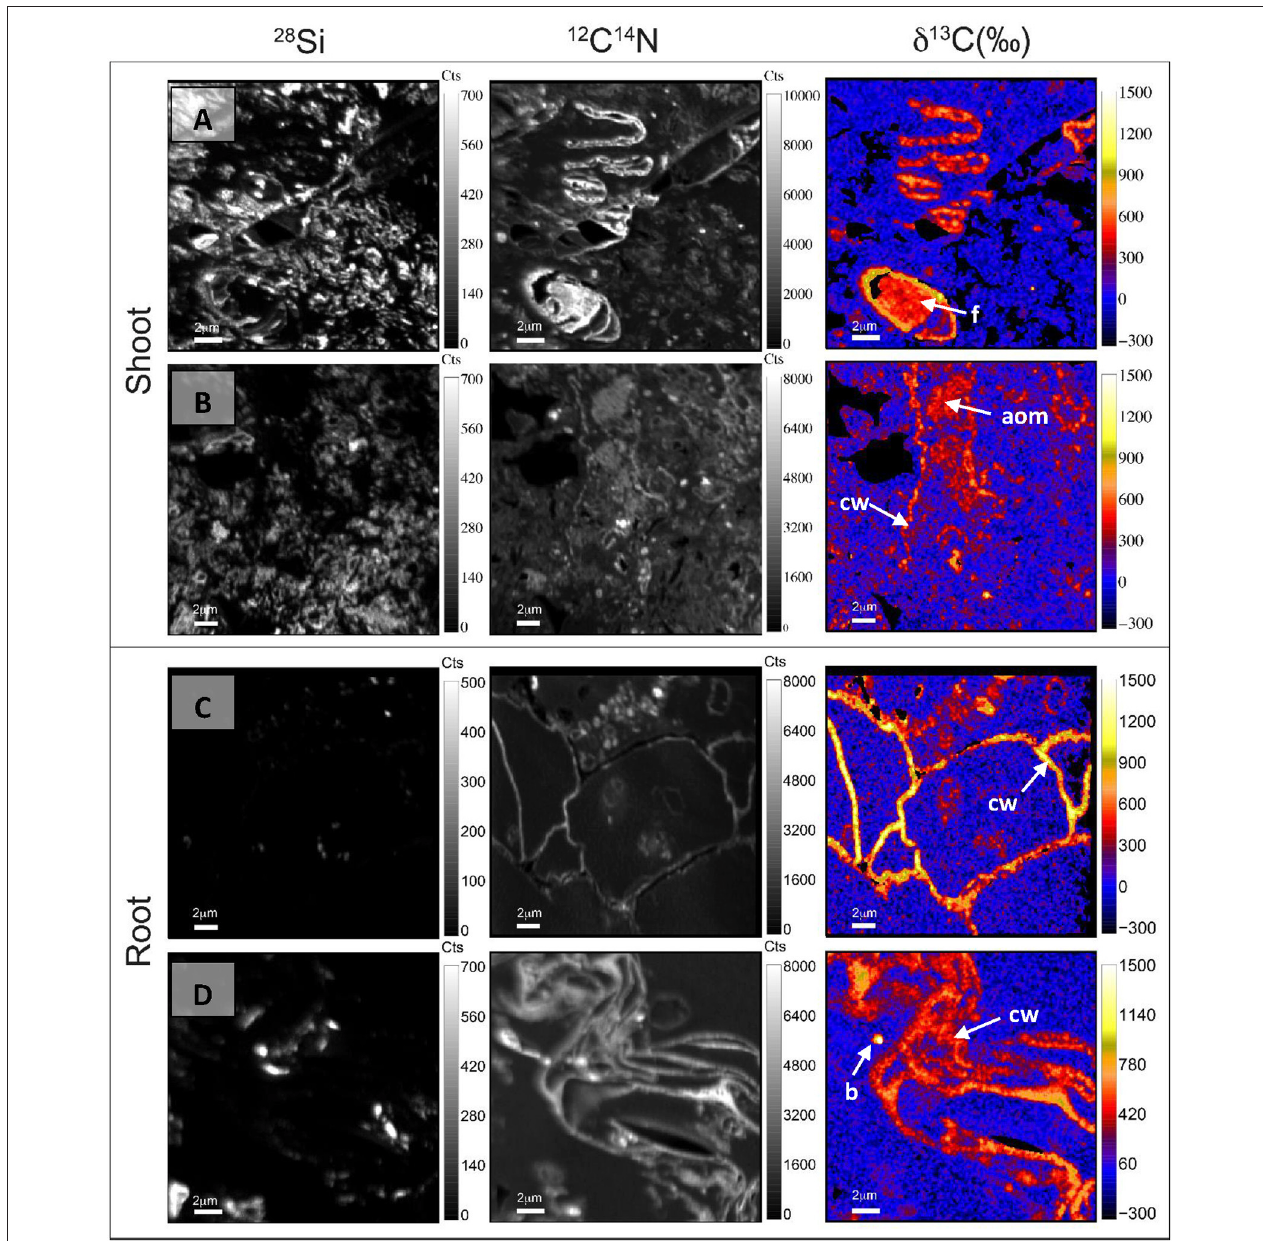
FIGURE 4 | NanoSIMS maps of 28 Si − , 12 C 14 N − , and δ 13 C illustrating contrasted degradation stages of labeled plant tissues and microorganisms implied in their decomposition, after 8 weeks of experiment, for both Cast-Shoot (A,B) and Cast-Root (C,D) . aom, amorphous organic matter; b, bacteria; cw, cell wall; f, fungus.